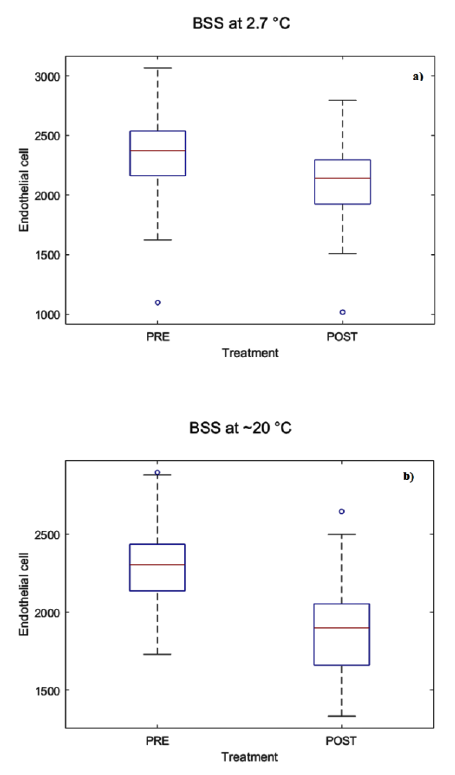
Figure 1. The distribution of endothelial cells with balanced salt solution (BSS) at 2.7 ◦ C ( a ) and at ~20 ◦ C ( b ), pre- and post- treatment.